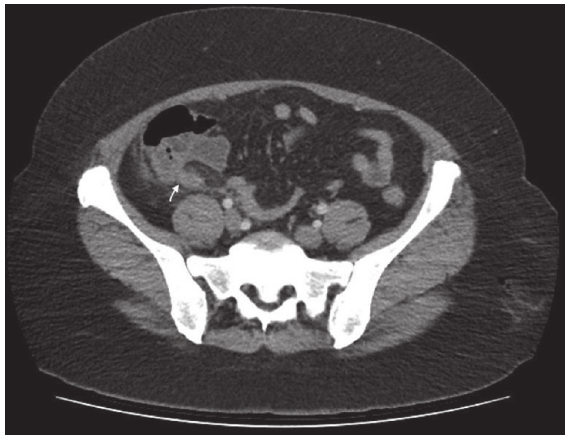
Figure 3: CT findings consistent with the diagnosis of acute appendicitis are